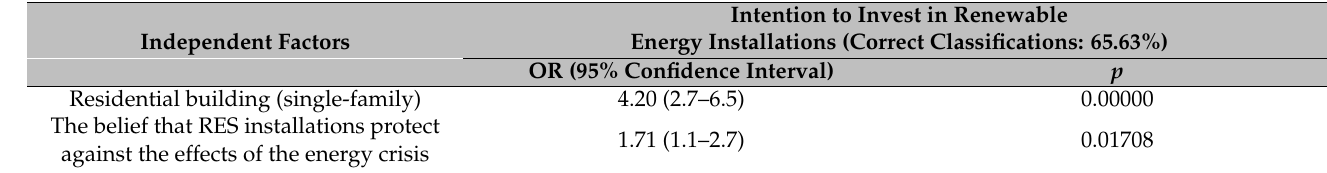
Table 5. Factors influencing the intention to invest in renewable energy